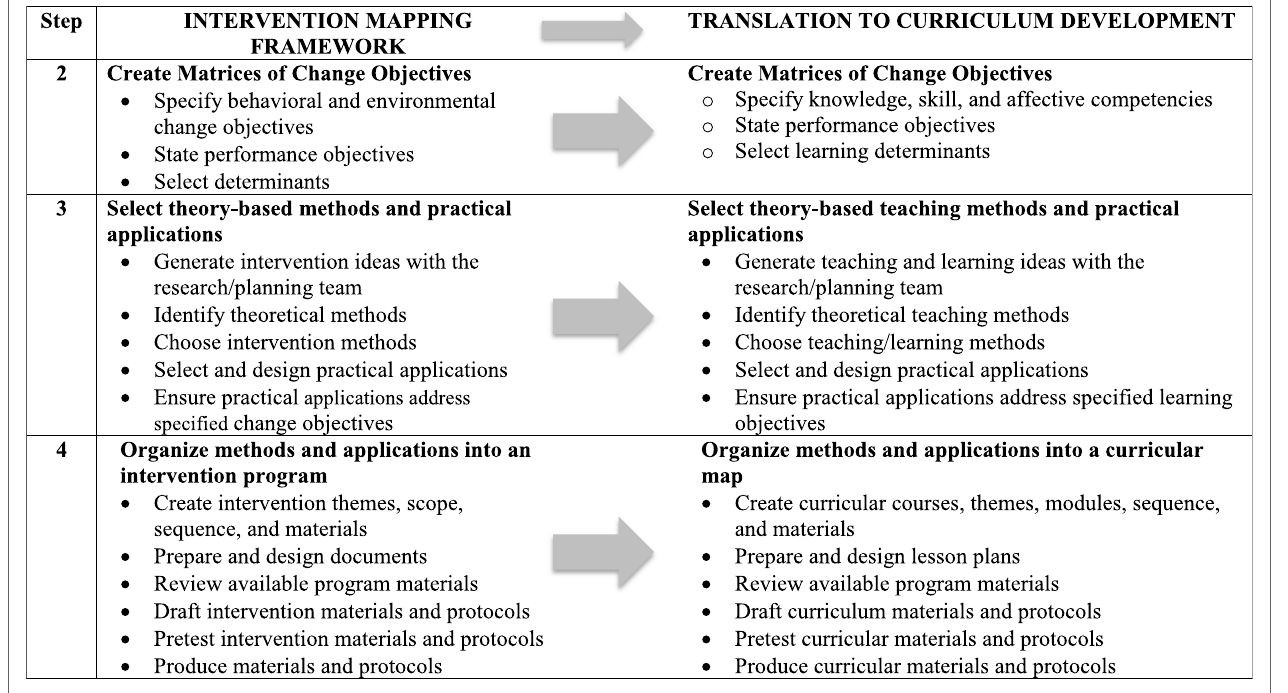
Figure 2 | Intervention Mapping framework translating Steps 2–4 applied to curriculum development. taBle 1 | Example of Intervention Mapping Step 2 with MPH integrated core curriculum. Competency Performance outcomes learning determinants Recognize biological, behavioral, environmental, socioeconomic, cultural, and other factors that impact human health, influence the global and societal burden of disease, and contribute to health disparities across the